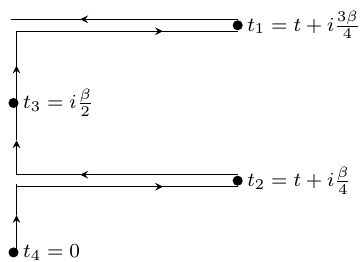
Figure 7. Double Keldysh-Schwinger contour with operators equally spaced in imaginary time. (Note that here we use the convention that the real/imaginary part of t is the real/imaginary time, which is di(cid:11)erent from our convention in previous